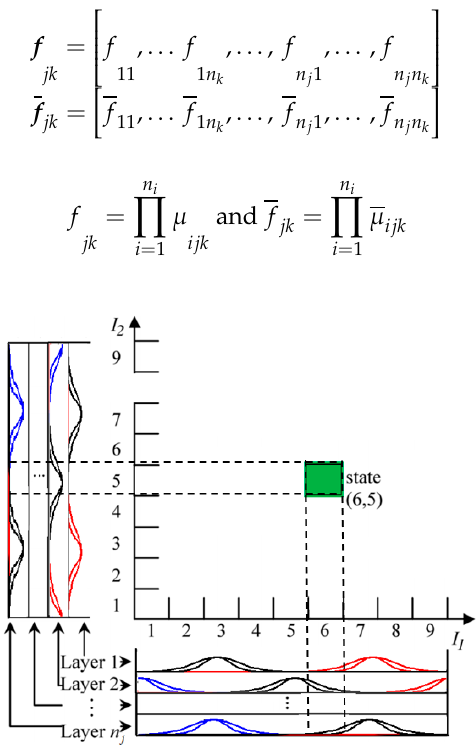
Figure 3. The operation of simple Petri net (PN).